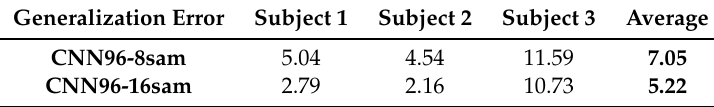
Table 4. Generalization errors for the examined subjects (in